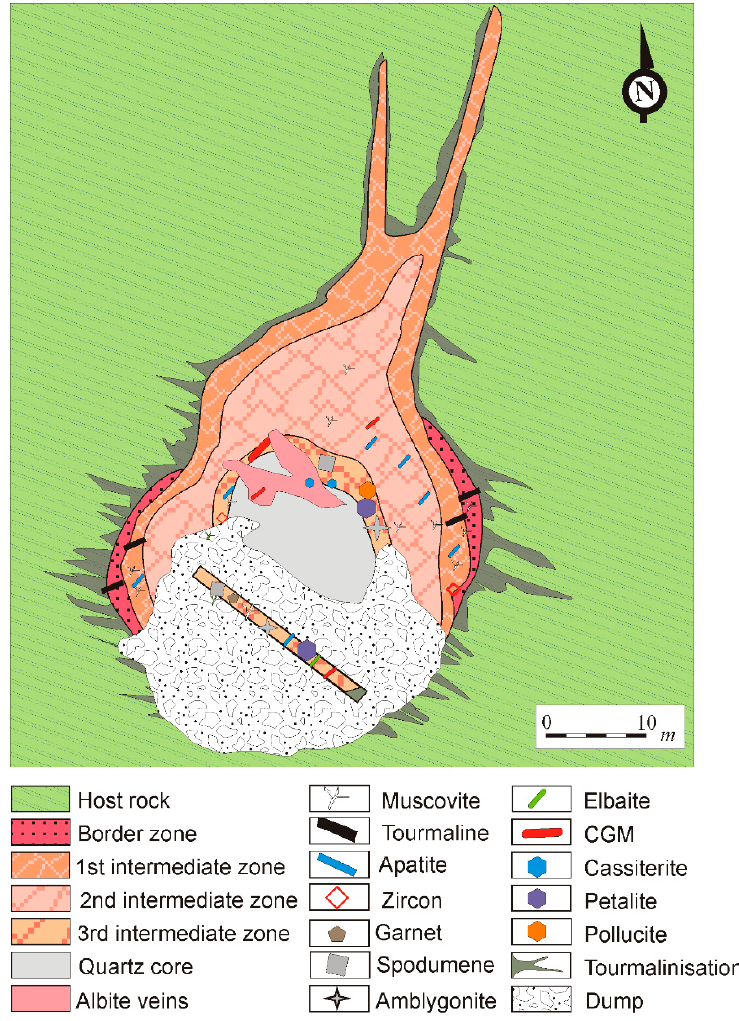
Figure 8. Conceptual scheme (not to scale) of the various pegmatite units in the type-V pegmatite and distribution of the most significant minerals.